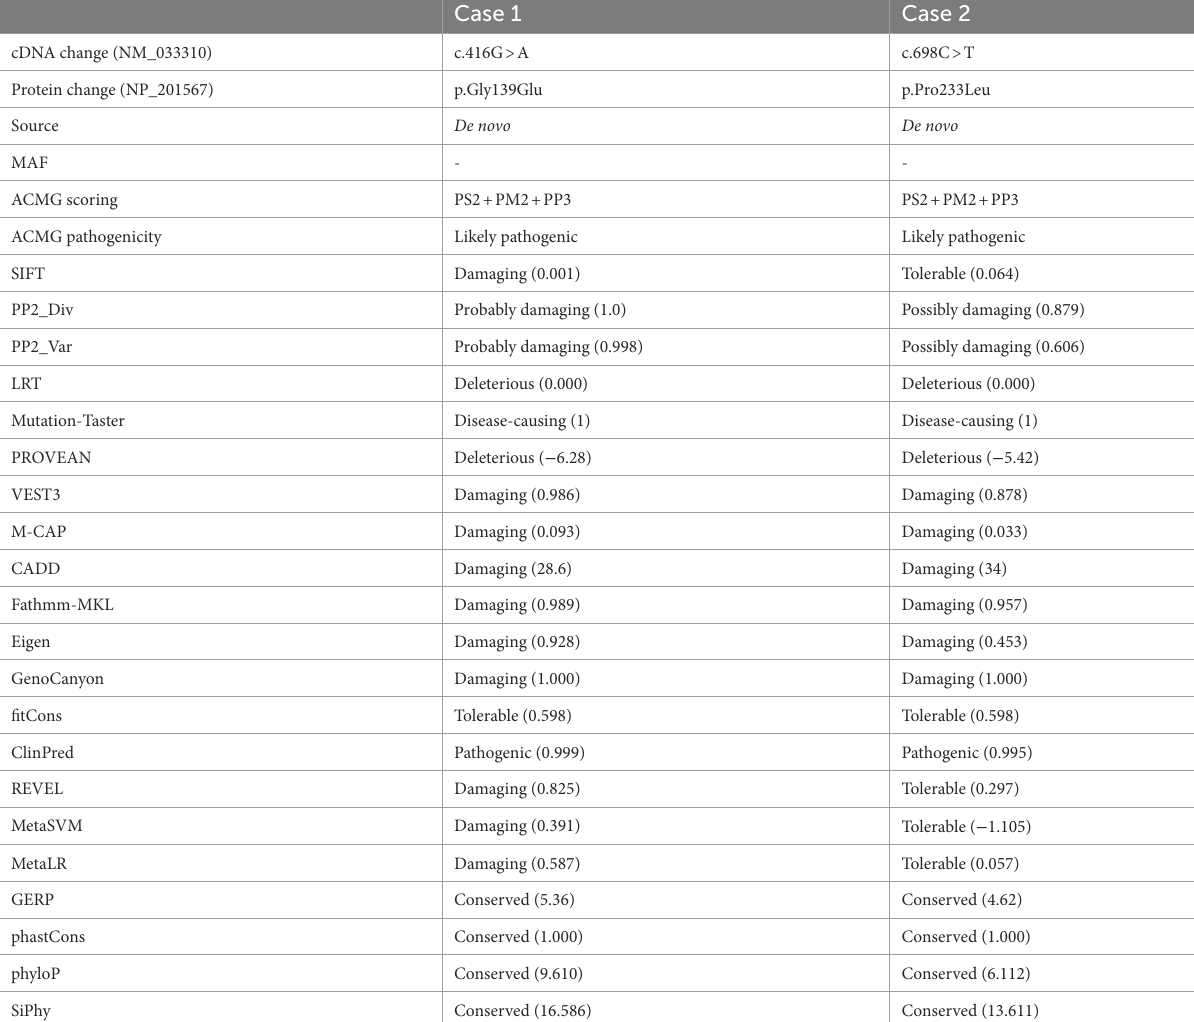
TABLE 3 Genetic characteristics and ACMG scoring of the KCNK4 variants identified in this